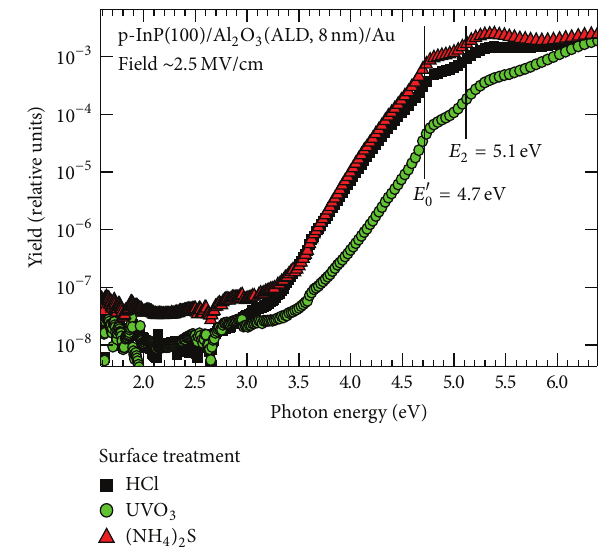
Figure 28: Cube root of the IPE yield as a function of photon energy as measured at different bias applied to the (100)InAs/a-Al 2 O 3 (20 nm)/Au capacitor which are used to determine the spectral thresholds. The inferred thresholds Φ 𝑒 (low/high) of electron IPE from the VB of InAs into the CB of a-Al 2 O 3 are indicated by vertical lines. Lines guide the eye.